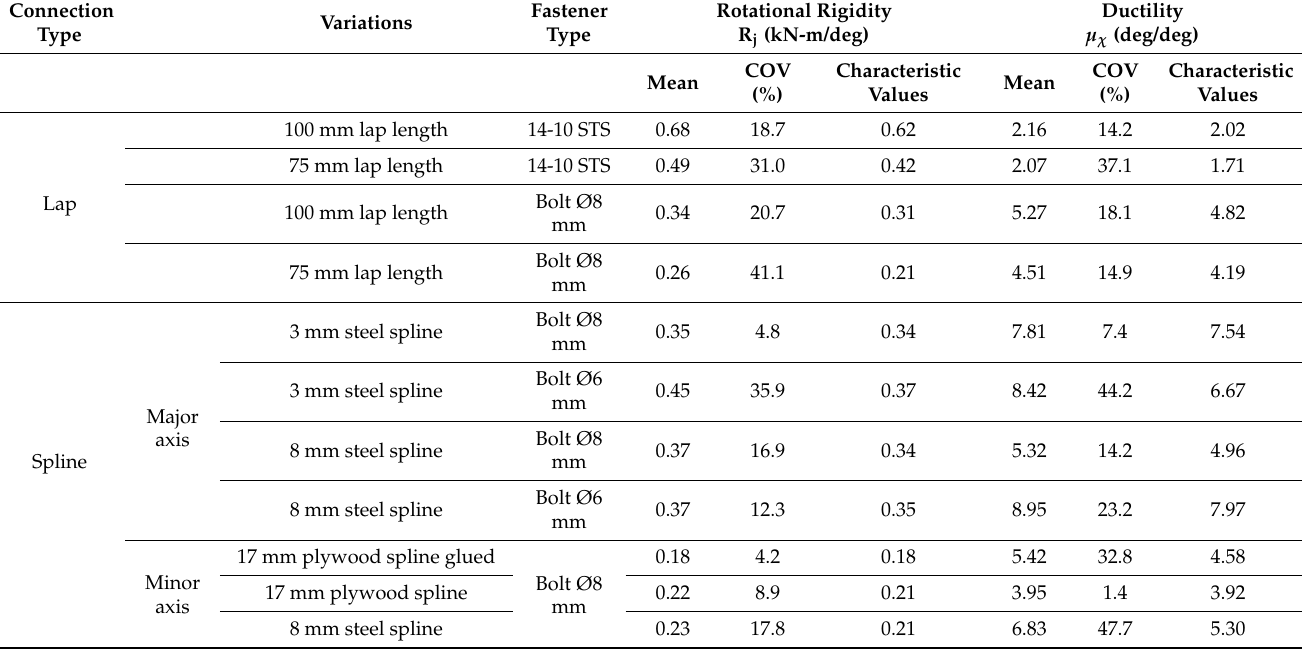
Table 5. The mean and characteristic values of the rotational rigidity and ductility of all of the connections.